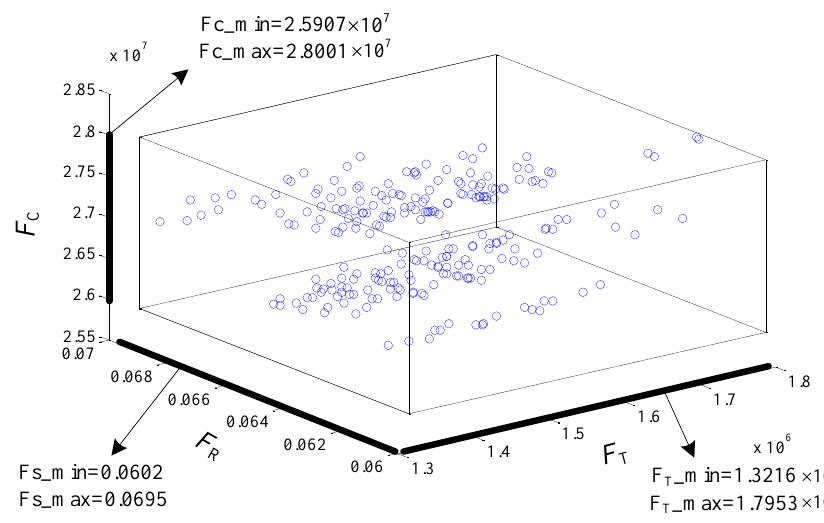
Figure 8. Multi-objective space of the effective plans.